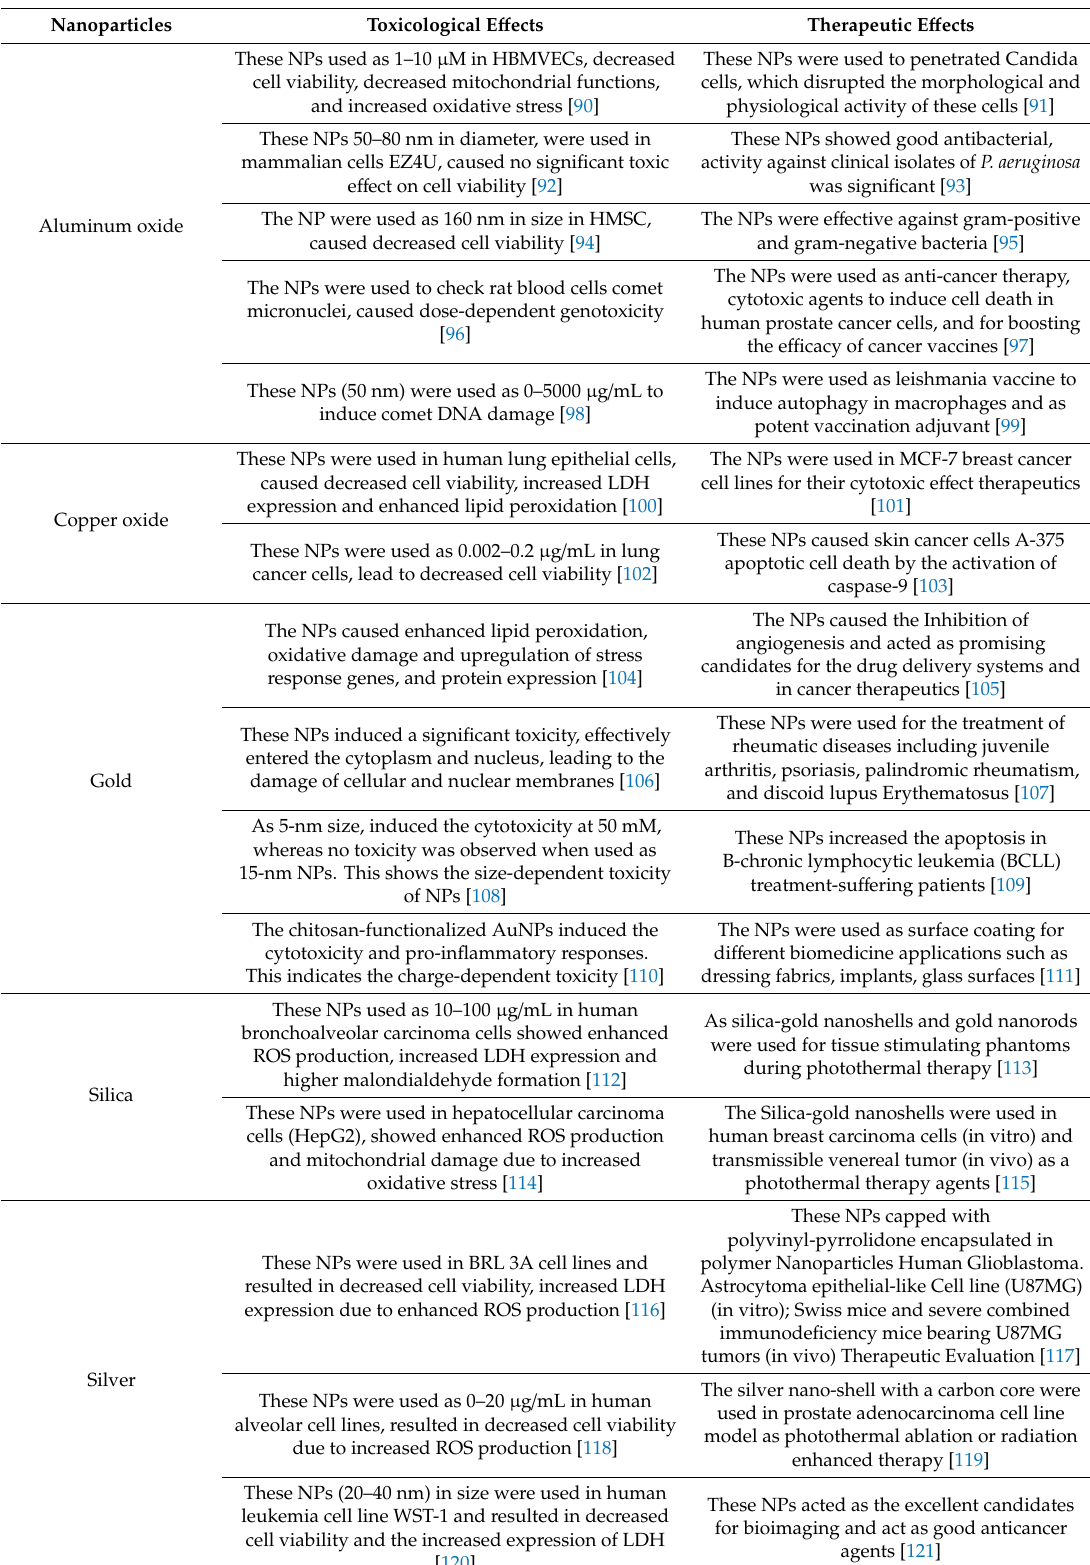
Table 2. The toxicological and therapeutic e ff ects of di ff erent types of nanoparticles.